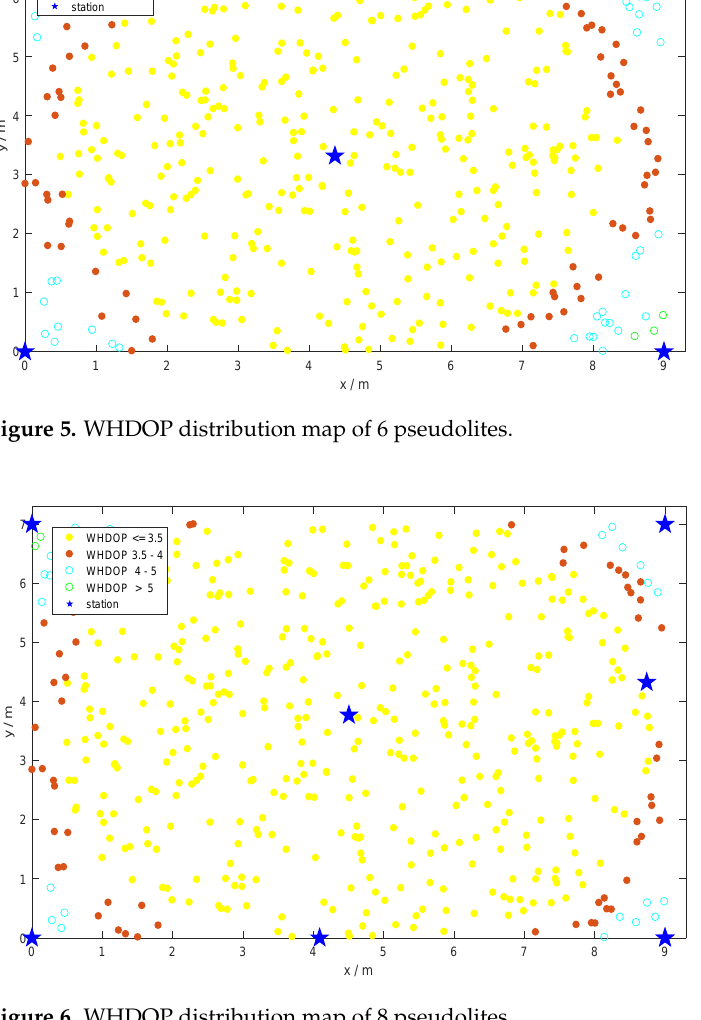
Figure 6. WHDOP distribution map of 8 pseudolites. Table 3. Distribution of WHDOP values using the proposed method under six pseudolites and eight